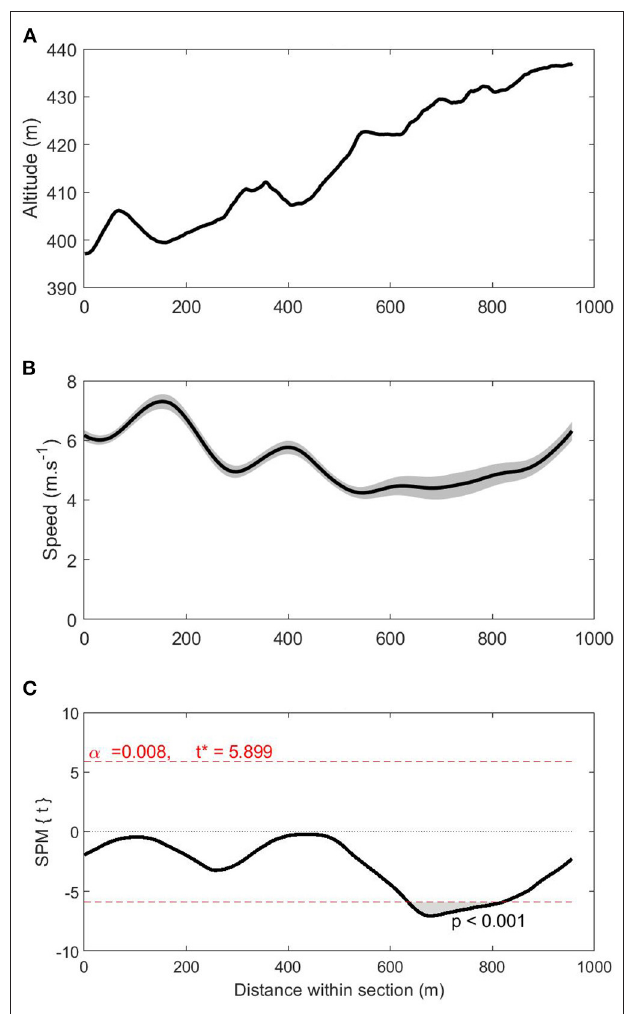
FIGURE 3 | Altitude (panel A ), speed (panel B ), and statistical parametric mapping (SPM{t}) curves (panel C ) for the men in S1 on lap 2 (i.e., the course section where race time was significantly related to instantaneous skiing speed). The shaded area on the speed curve represents the 95% confidence interval. The shaded area on the SPM{t} curve shows the course location where a significant relationship exists between race time and instantaneous speed (at 635–819m). * p <